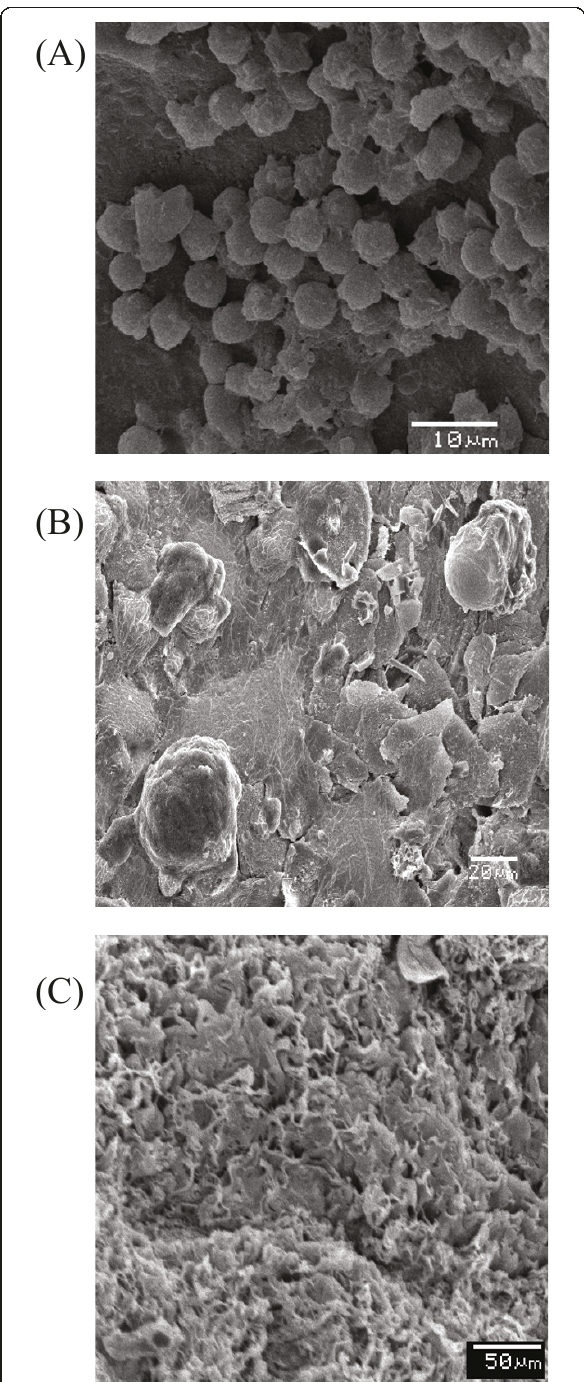
Figure 5 MEV of the vaginal epithelium of hyperestrogenic Wistar rats after infection with Candida albicans . In (A) many yeasts adhered to the epithelium. In (B) larger detail of the adhesion of C. albicans to the anucleate cells of the vaginal epithelium, characteristic for the state of pseudo-estrus. In (C) epithelium composed only of anucleate scales, without yeasts, after treatment with fluconazole and with the extracts from S. saponaria